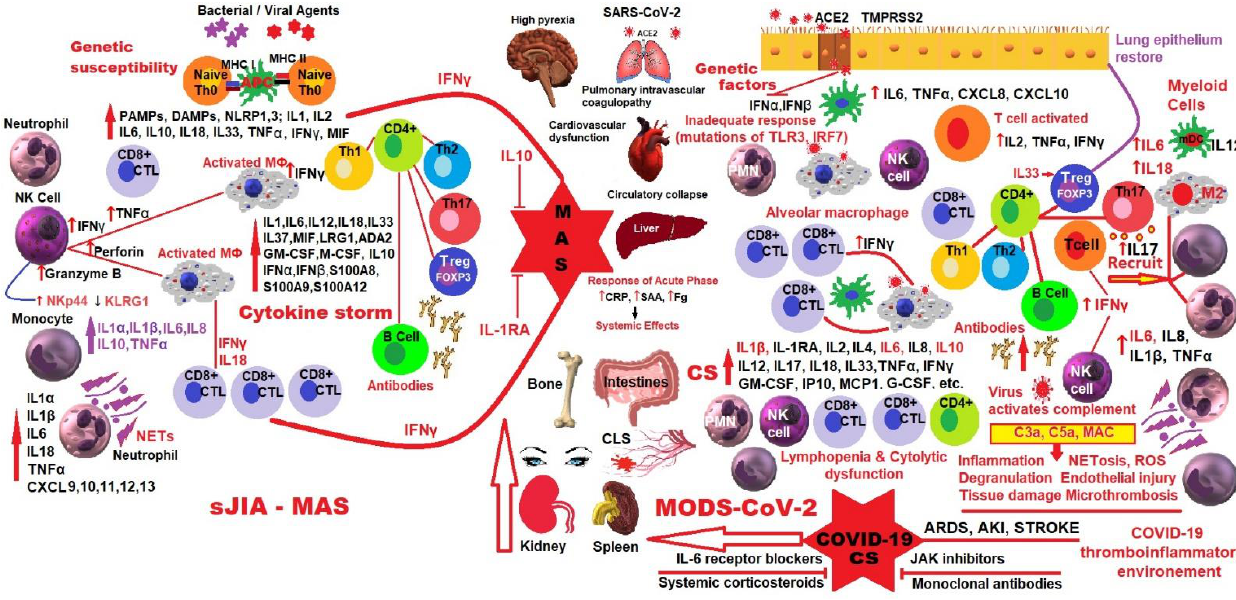
Figure 1. Complex cytokine storms in sJIA-MAS and COVID-19-CS and secondary organ dysfunction, ↑ Increased; ↓ Decreased (the figure was imagined and drawn by L.M.A. using Microsoft Paint 3D (3D Library — Biology: human heart and brain) for Windows 10 and also using completely free picture material (human lungs, kidney, eyes, intestines, CLS and bone clip arts) from SeekPNG.com (accessed on 31 January 2022), for which we are very grateful).